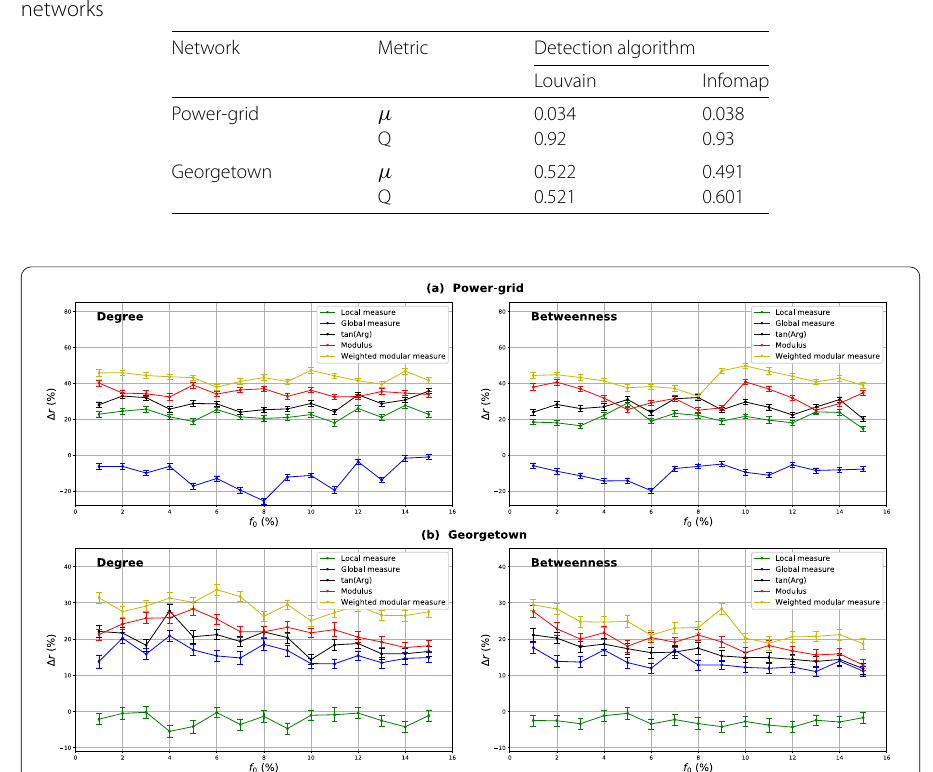
Figure 7 The relative difference of the outbreak size (cid:8) r as a function of the fraction of initial spreaders f 0 . The Degree and Betweenness centrality measures derived from the Modular centrality are compared to their classical counterparts. The measures are performed on Power-grid network in ( a ) and Georgetown network in ( b ) for the Infomap